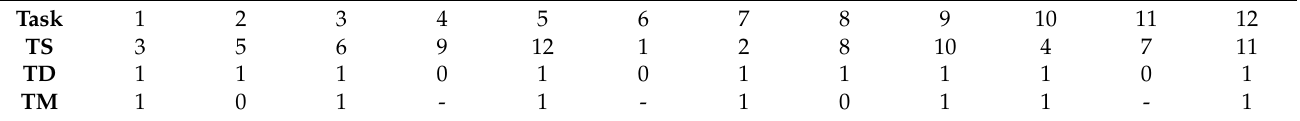
Figure 2. Disassembly precedence diagram. Table 1. Encoding vector.